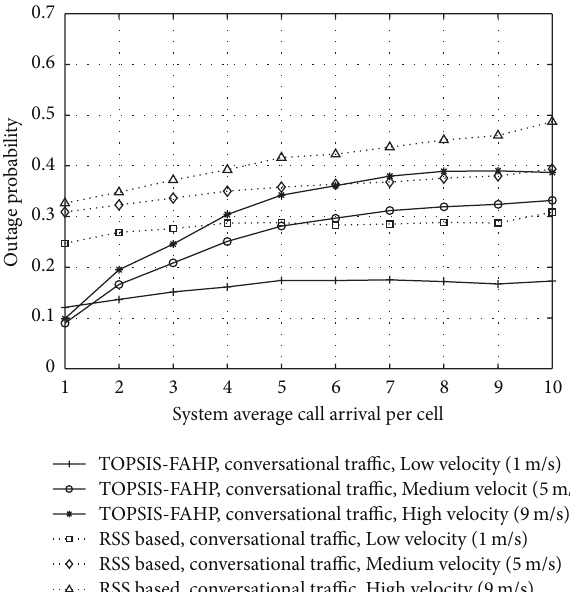
Figure 6: Outage probability using